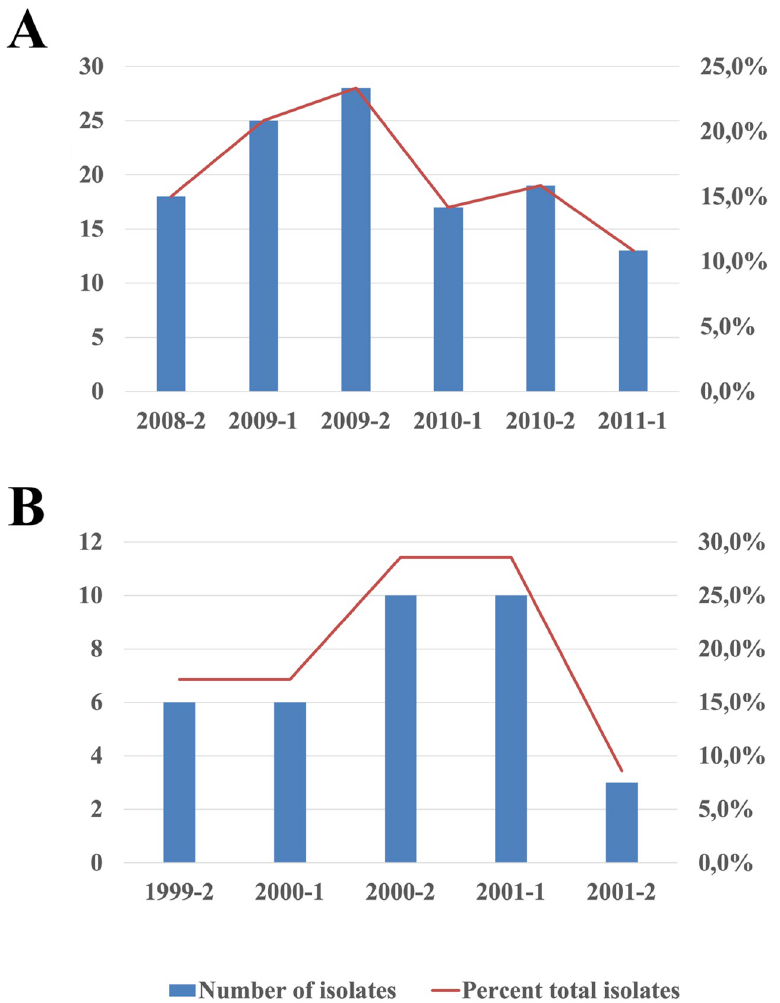
Fig 1. Time distributions of L . braziliensis isolations for the primary (2008–2011) and validation (1999–2001) parasite samples used in the study. (A) Primary sample of parasite isolates obtained from ATL patients enrolled during six consecutive semesters from July/2008 to June/2011 in Corte de Pedra, Northeast Brazil. (B) Validation sample obtained from ATL patients enrolled during five consecutive semesters from July/1999 to December/2001 in the same region. Columns depict the number of isolates obtained per semester, according to the left Y axes. Lines consist in percent contribution of each semester to the total number of isolates in the corresponding sample, according to right Y